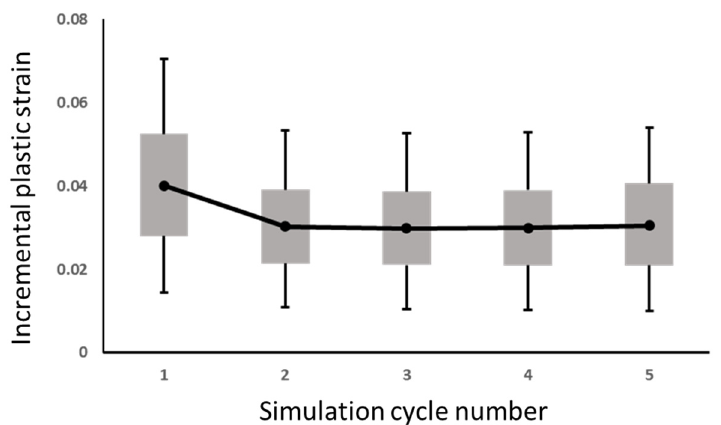
Figure 9. The boxplot of the plastic strain incremental of the 81 data points [15] (Copyright 2020 EuroSimE).